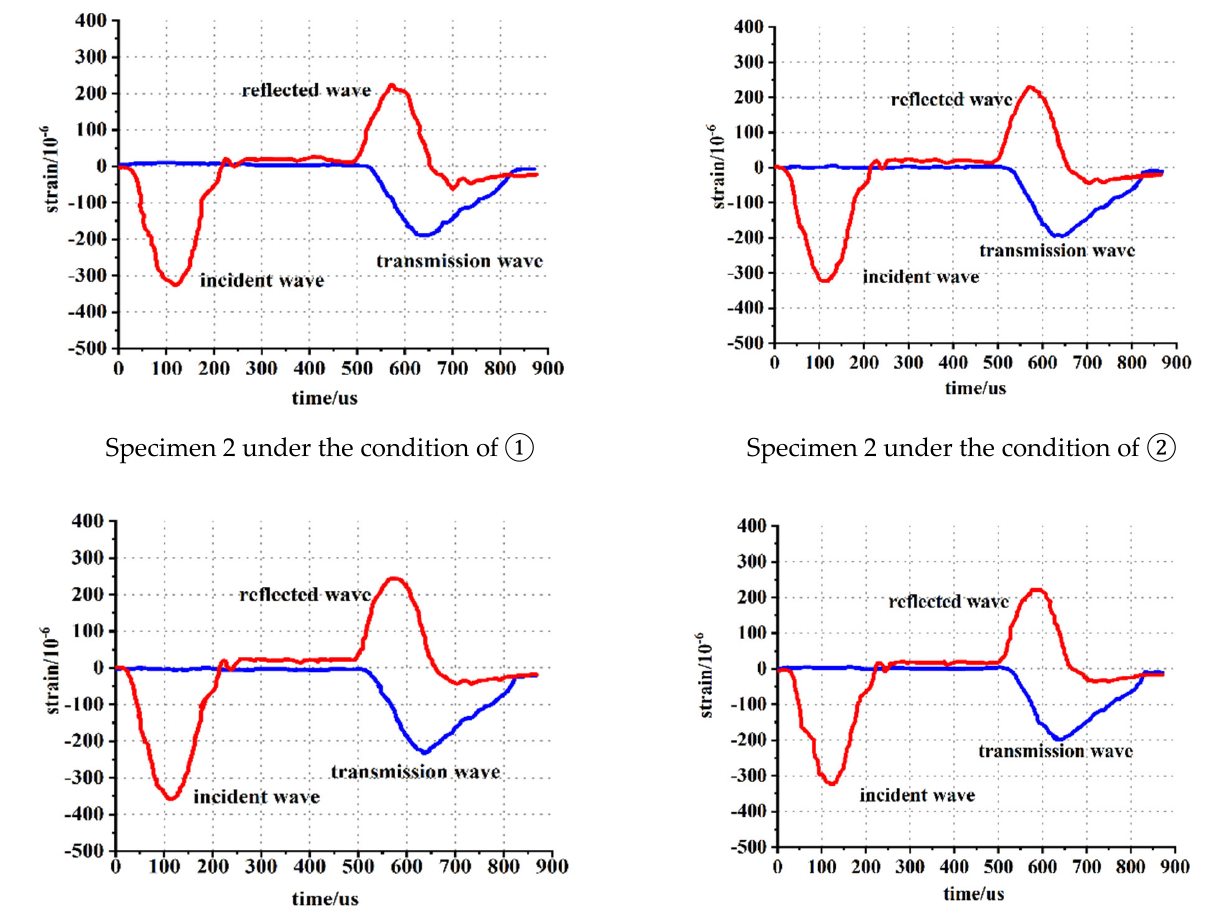
Figure 8. Time − history curves of three − wave strain of specimens under different loading conditions.